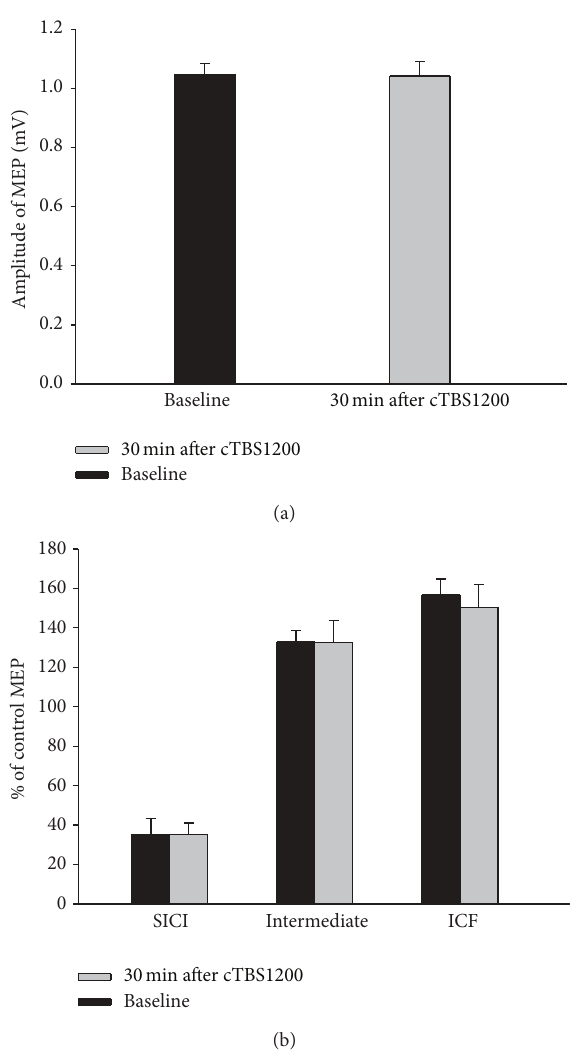
Figure 2: No changes on either TMS-induced MEP or SICI/ICF by EcTBS1200. There is no significant change on MEP (a) and SICI/ICF (b) after EcTBS1200.